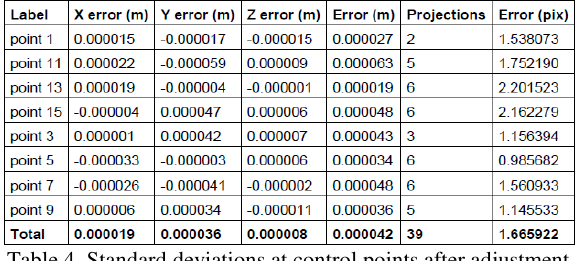
Table 4. Standard deviations at control points after adjustment